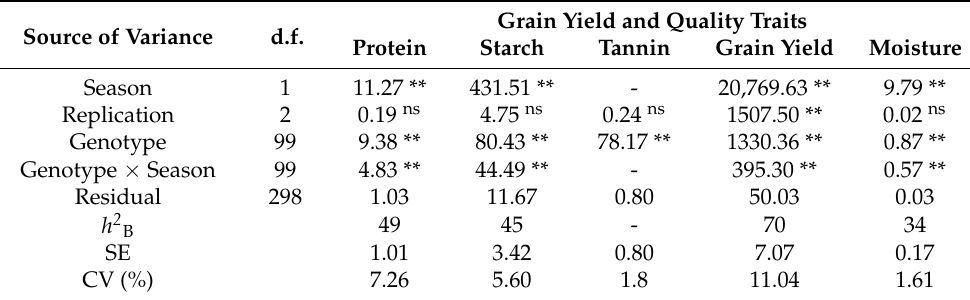
Table 1. Mean squares from the analysis of variance of 100 sorghum accessions evaluated for grain yield, protein, starch, moisture and tannin contents.